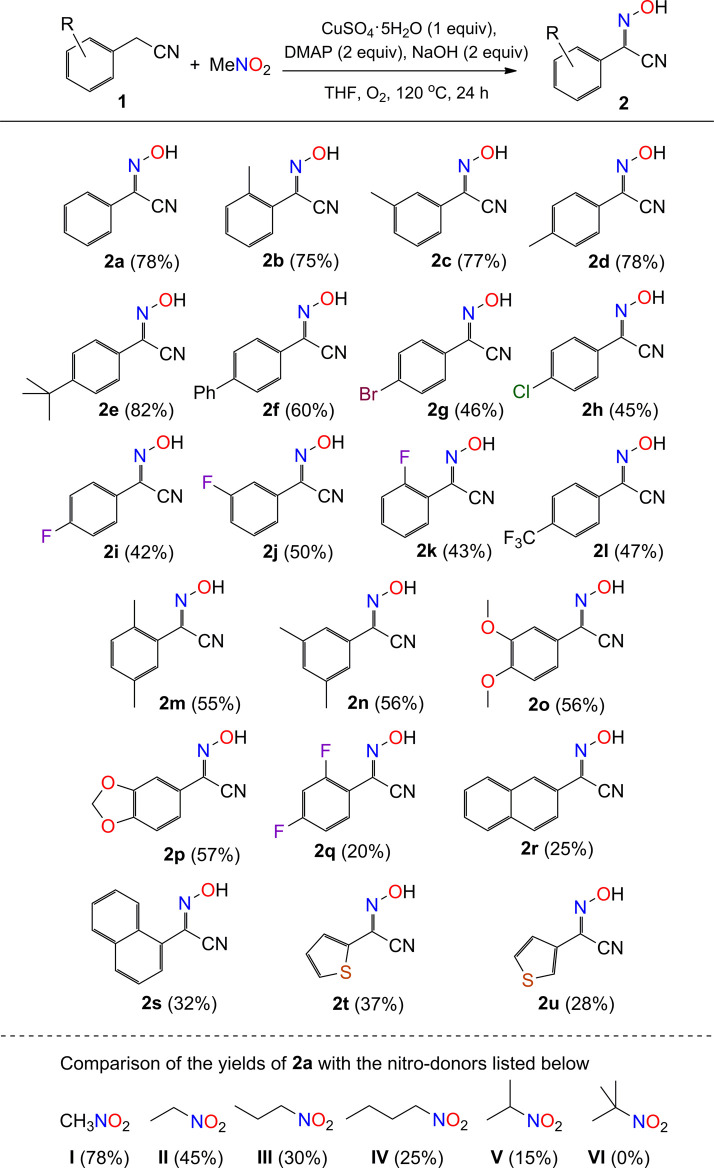
Scope of phenylacetonitriles with respect to compound 2a. aReaction conditions: substrate 1 (0.6 mmol), MeNO2 (0.2 mmol), CuSO4.5H2O (0.2 mmol), DMAP (0.4 mmol), NaOH (0.4 mmol), THF (1 mL), O2 (1 atm), 120 °C, and 24 h.